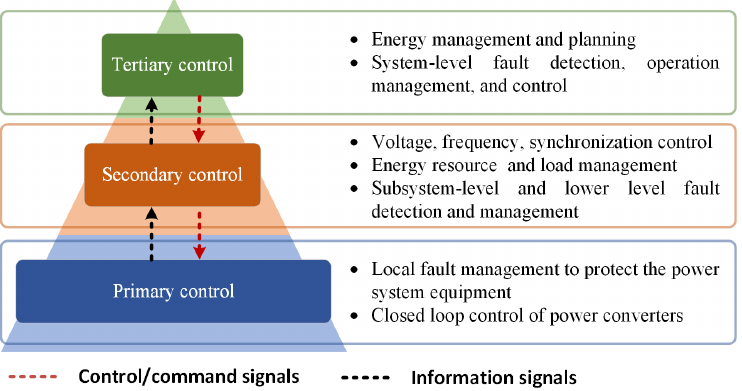
Figure 5. Hierarchical control